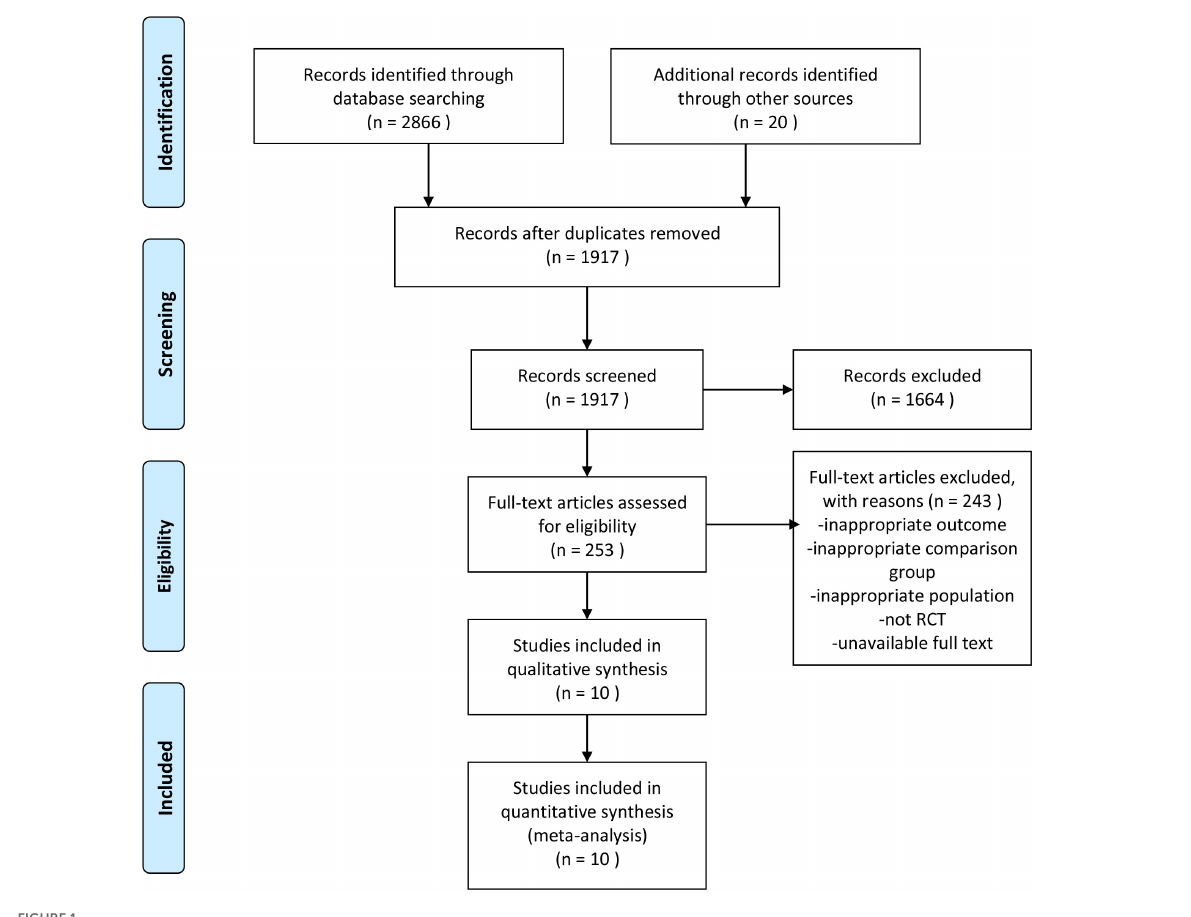
FIGURE1 Flow diagram of study